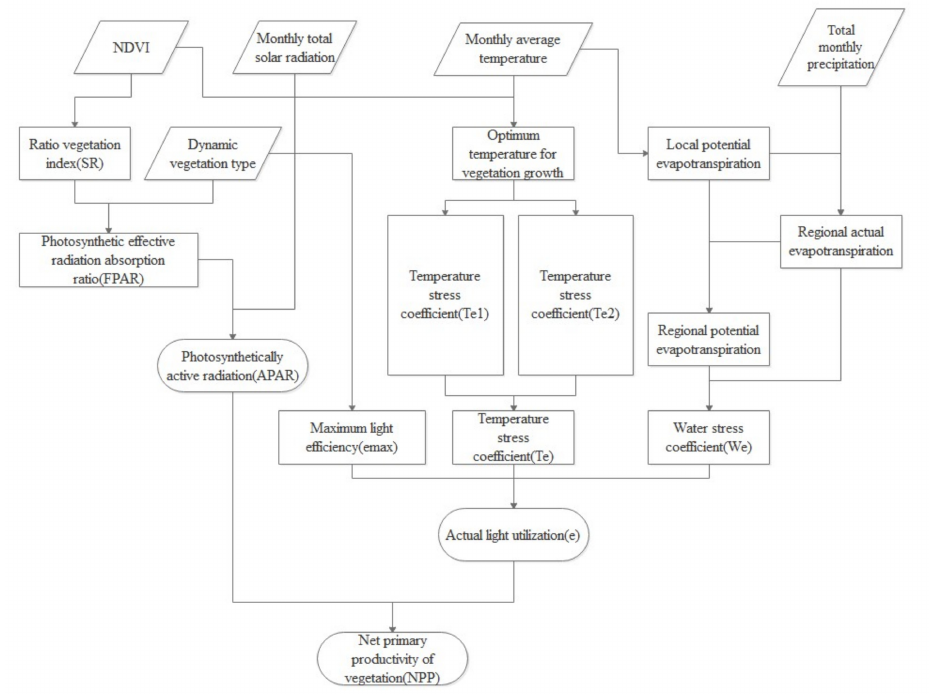
Figure 2. Flowchart of the CASA